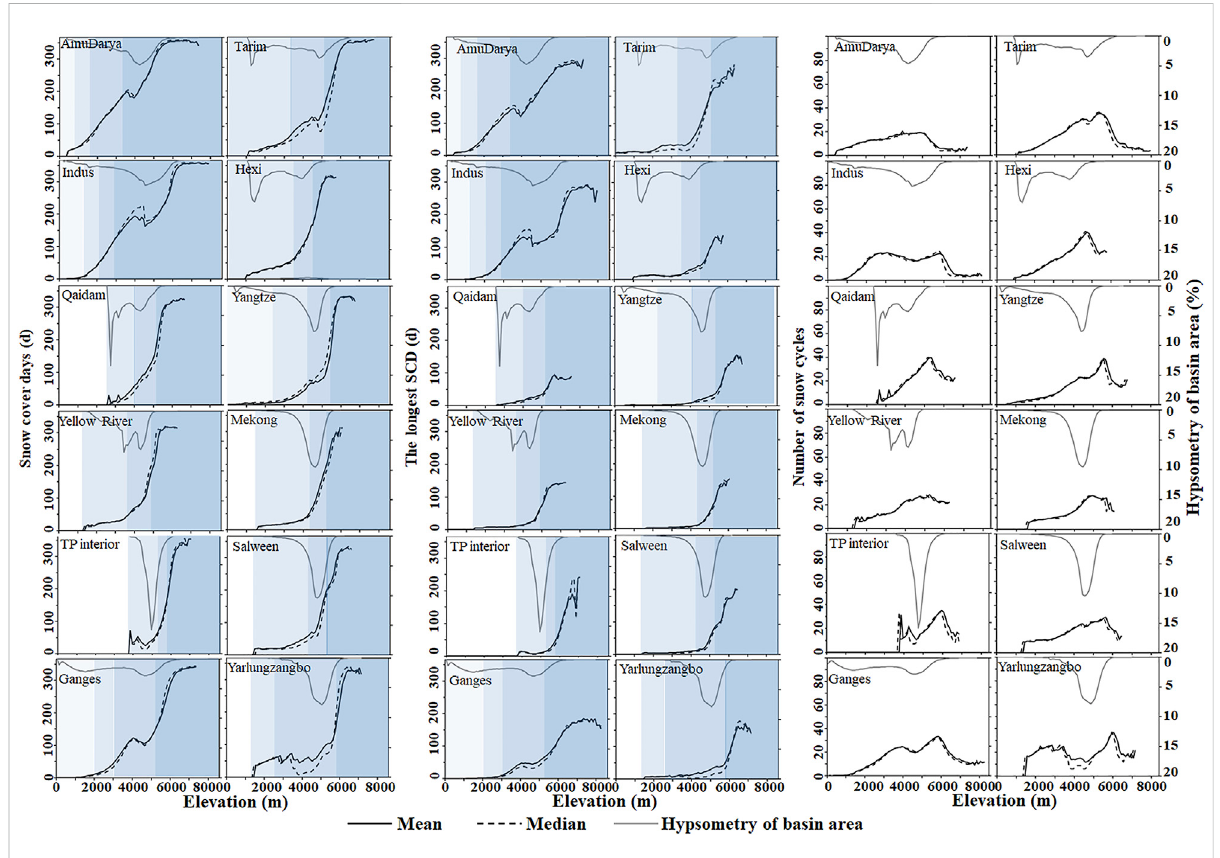
FIGURE 5 Snow cover days, the longest SCD, and number of snow cycles in each basin of the Tibetan Plateau.